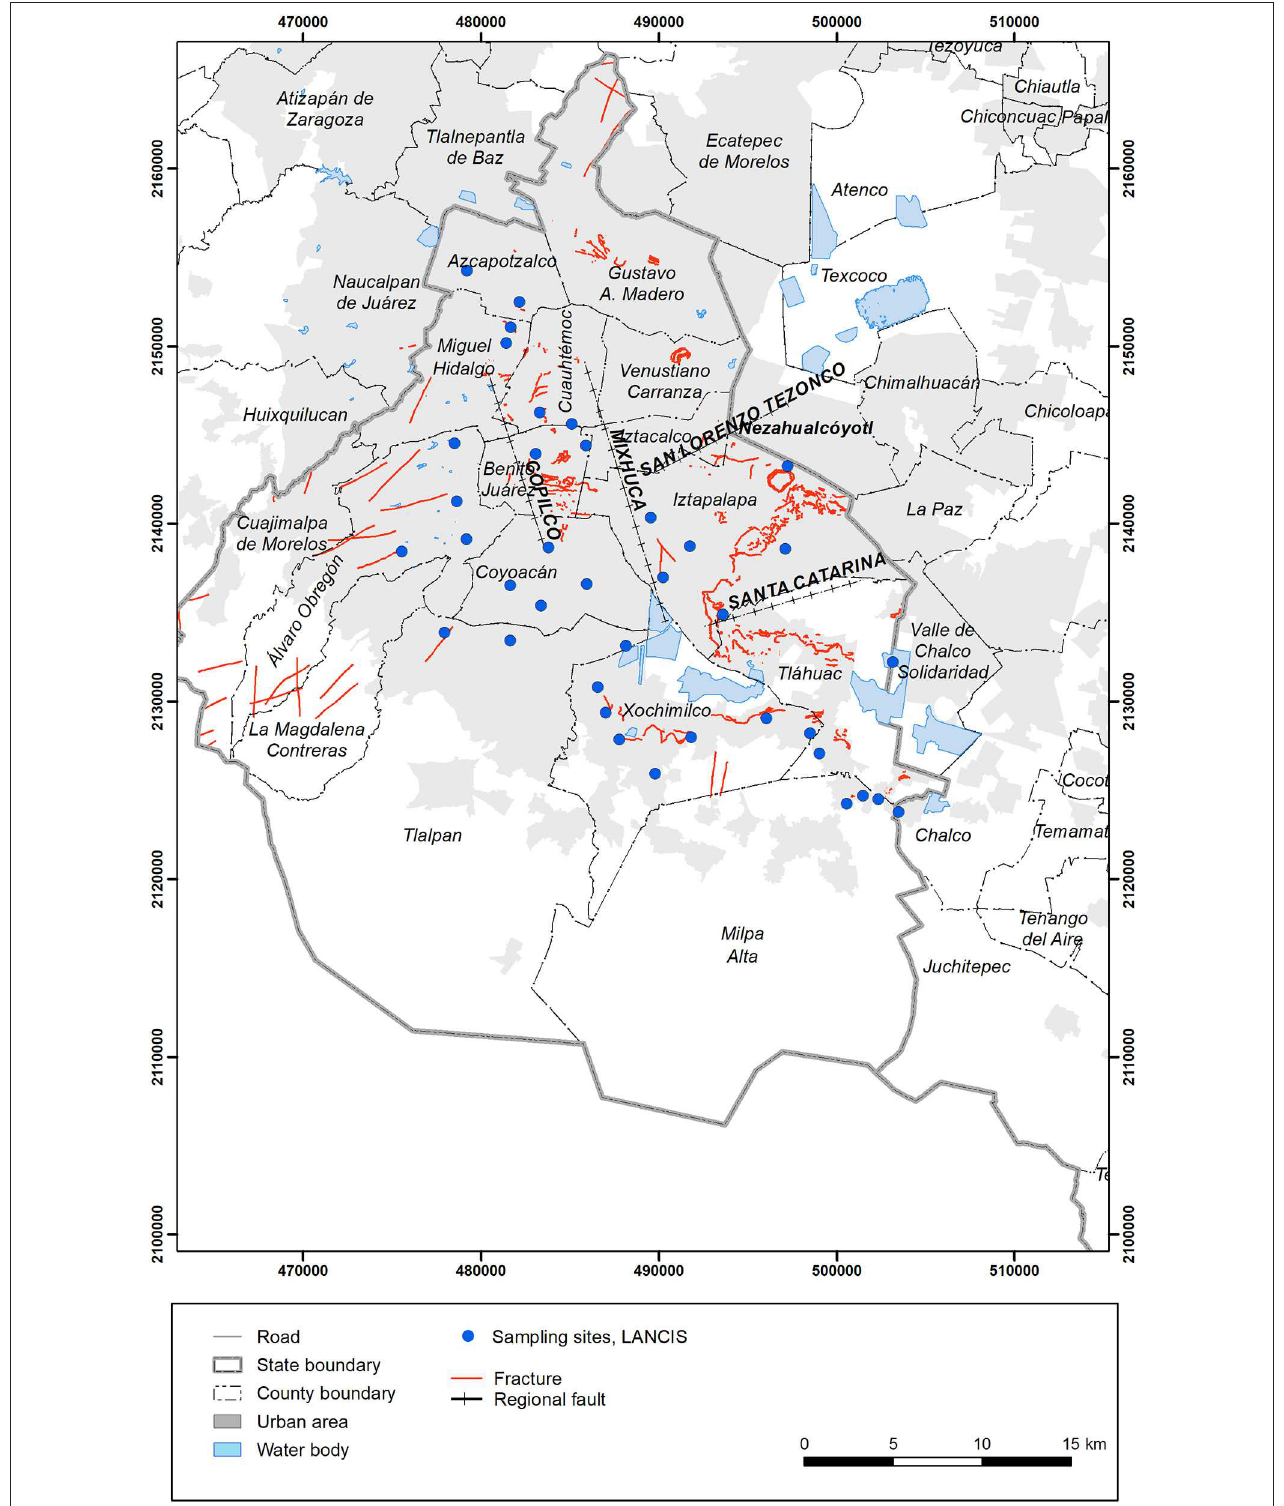
FIGURE 1 | Spatial location of the selected wells (blue dots) to carry out a water quality sampling campaign. Fractures in red and geologic faults in black (based on information in Table 1 ).